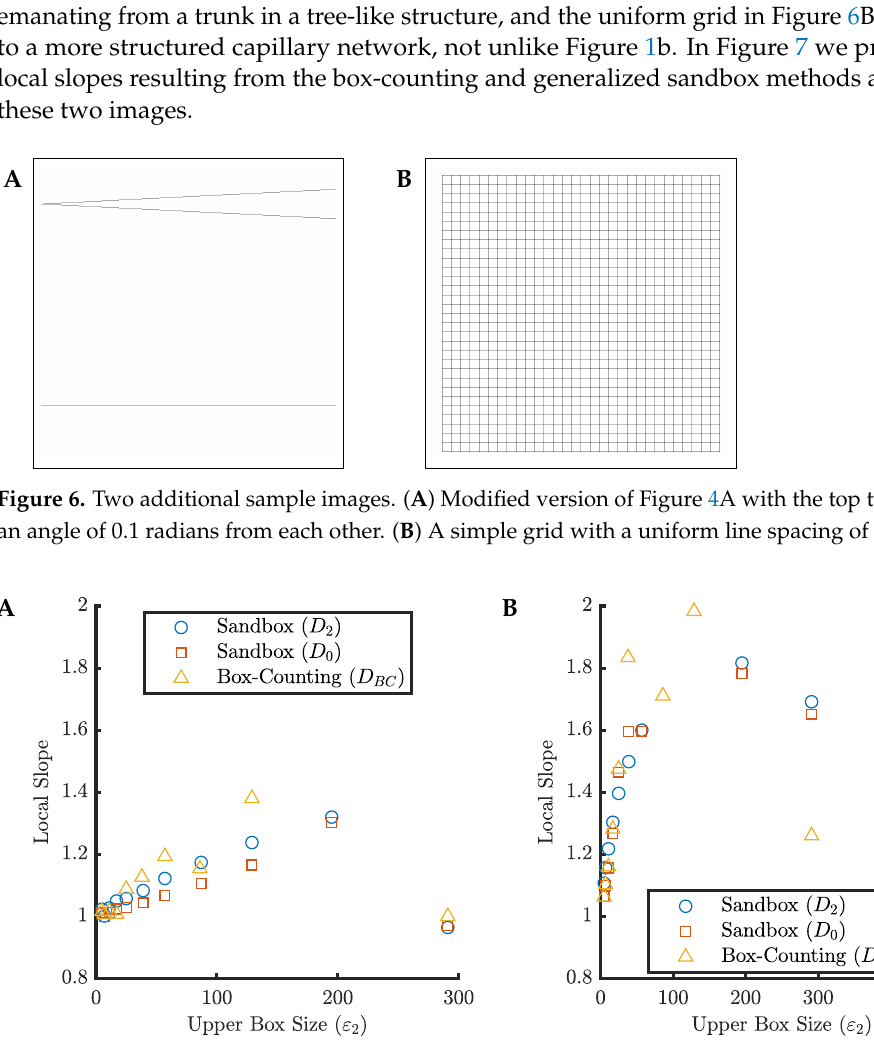
Figure 7. Plots showing the local slopes as a function of ε 2 for both images in Figure 6. Slopes are computed using the generalized sandbox ( D 2 and D 0 ) and box-counting methods ( D BC ). ( A ) Local slopes for Figure 6A, estimates of dimension yield D 2 = 1.1034, D 0 = 1.0681, and D BC = 1.0844. ( B ) Local slopes for Figure 6B, estimates of dimension yield D 2 = 1.6484, D 0 = 1.6471, and D BC =